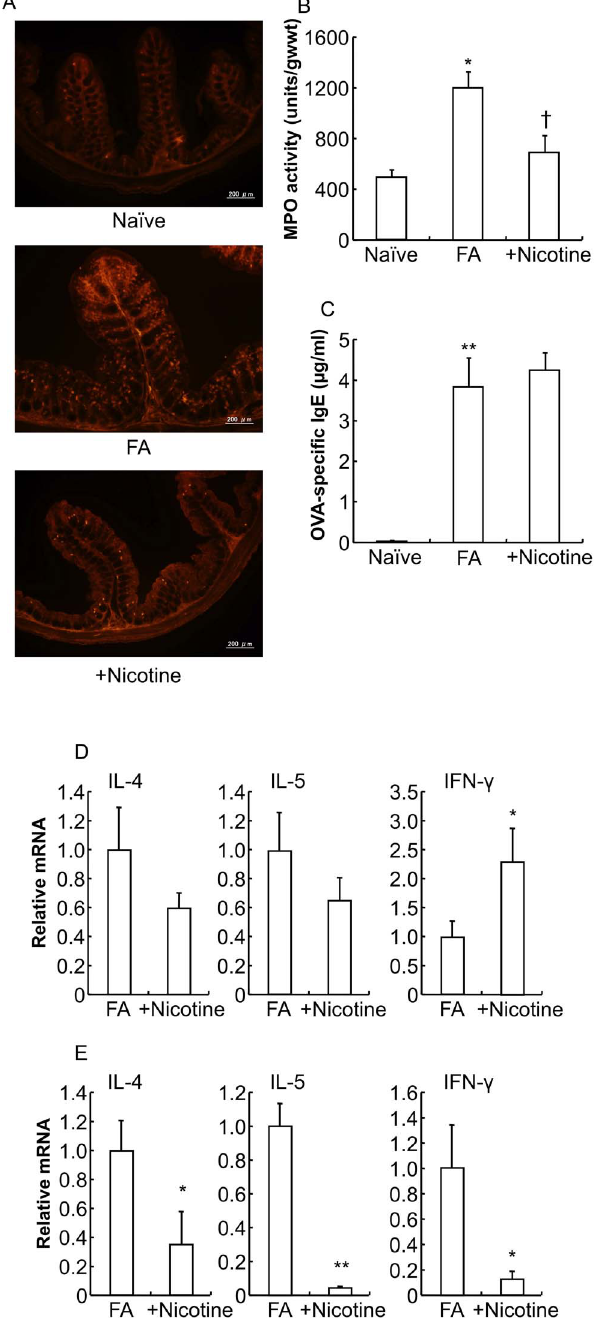
Figure 9. Effect of nicotine on the pathology of food allergy in mice. A : The proximal colons of naı¨ve mice, FA mice, and mice treated with the subcutaneous administration of nicotine were stained with mMCP-1 antibodies. Scale bars represent 200 m m. B : MPO activity was measured in the colon of naı¨ve mice, FA mice and nicotine-treated FA mice. * P , 0.01 vs. naı¨ve mice. { P , 0.05 vs. FA mice ( n =3–10 mice per group). C : The level of OVA-specific IgE in the plasma of naı¨ve mice, FA mice and nicotine-treated FA mice is shown. The level of OVA-specific IgE in the plasma was determined using an ELISA kit. ** P , 0.01 vs. naı¨ve mice ( n =5 mice per group). IL-4, IL-5 and IFN- c cytokine mRNA expression in the spleen ( D ) and proximal colon ( E ) from FA mice and nicotine-treated FA mice were measured by real-time PCR. Relative mRNA levels of cytokines were normalized to GAPDH expression. * P , 0.05, ** P , 0.01 vs. FA mice ( n =3–6 mice per